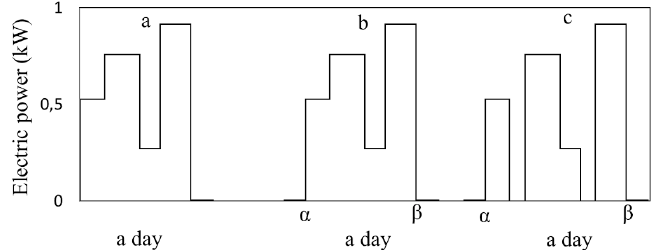
Figure 2. ( a ) Non-controllable; ( b ) schedulable; ( c ) curtailable loads.